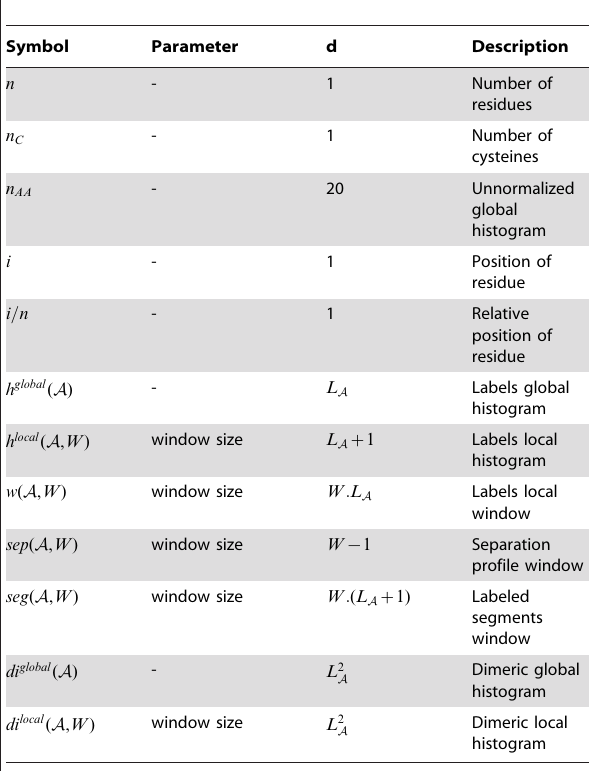
primary structure. Bottom: feature functions defined for every kind of annota- tion A [ f AA , PSSM , SS , SA g .